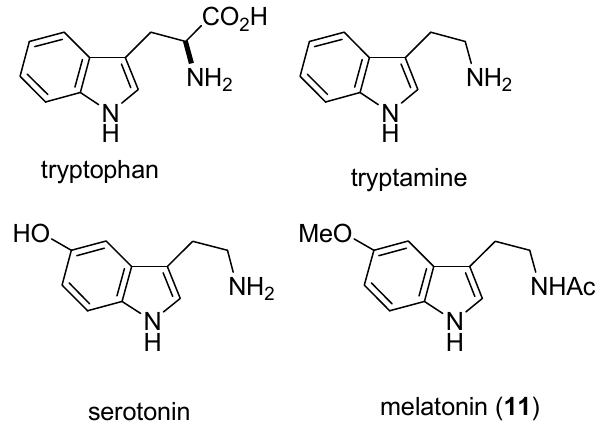
Figure 3. Structures of some naturally occurring indoles.